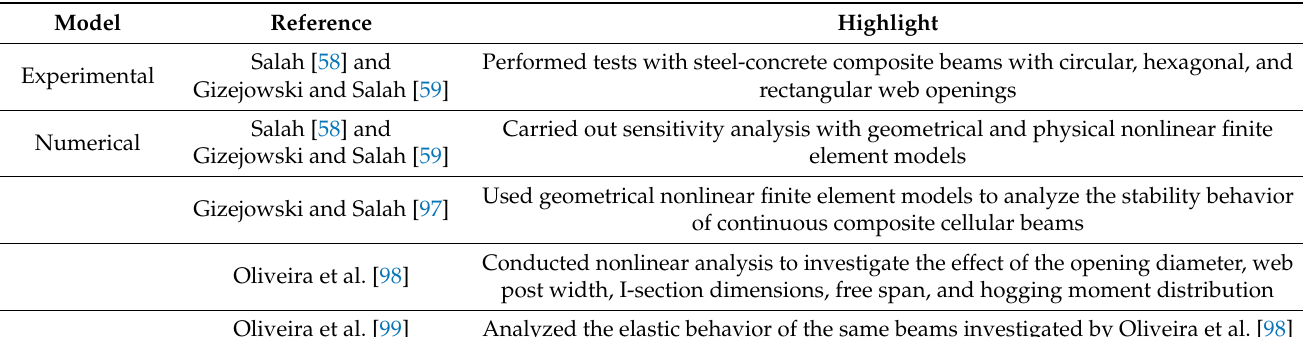
Table 1. Investigations on the LDB behavior of composite alveolar